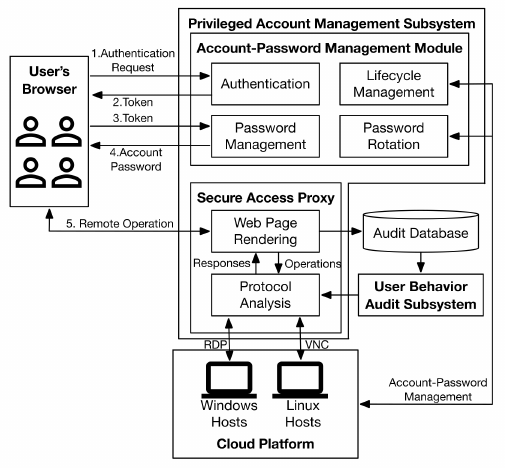
Figure 6. User-access process of Privileged Account Management